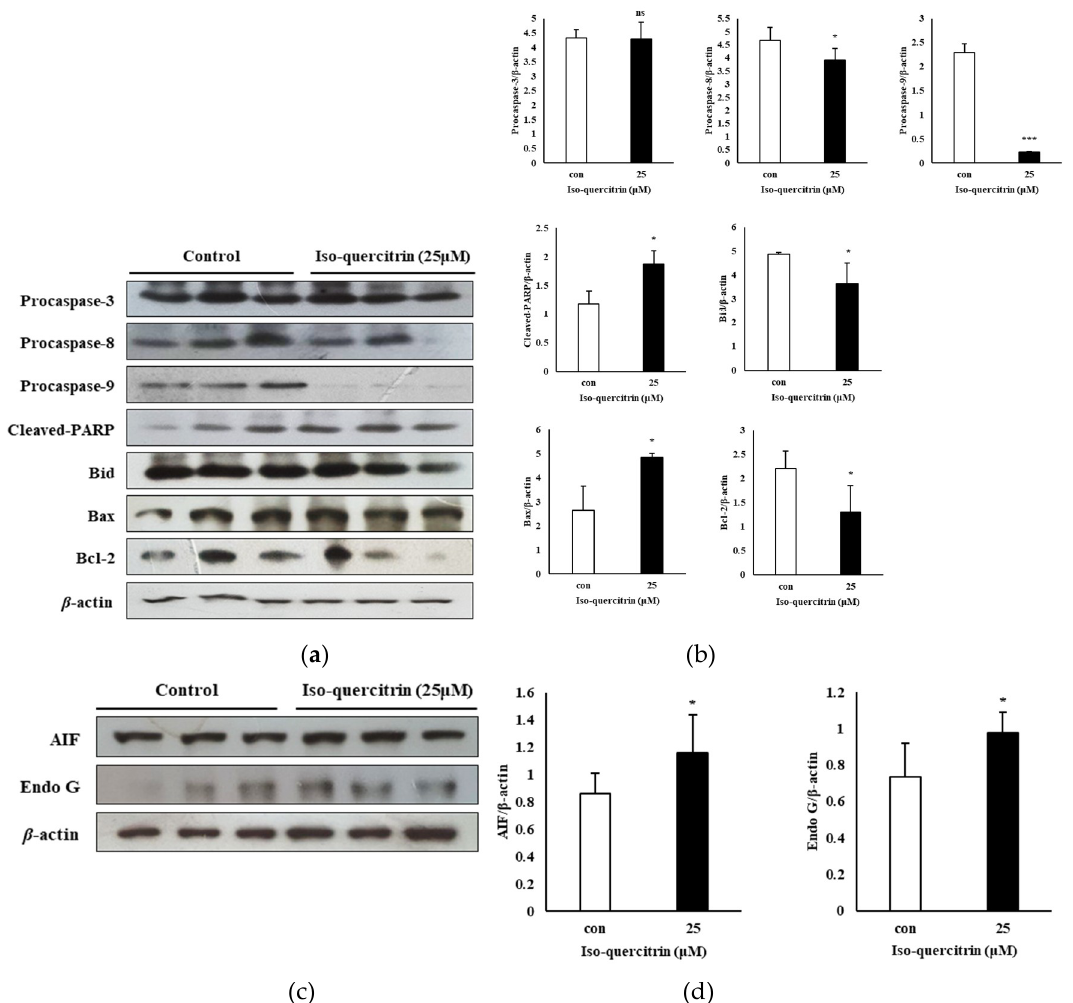
Figure 6. Isoquercitrin induces mitochondrial-mediated apoptosis in SK-MEL-2 cells. SK-MEL-2 cells were cultured in RPMI medium for 24 h and treated with 25 μM of isoquercitrin. Effect of IQ on the expression of ( a ) procaspase-3, -8, and -9, cleaved PARP, Bid, Bax, and Bcl-2; and ( c ) AIF and Endo G in SK-MEL-2 cells was analyzed through the western blot technique. ( b and d ) Total apoptotic proteins were quantified using the ImageJ software program. Results are expressed as a percentage. Data values are expressed as mean ± SD of triplicate determinations. Significant difference was established using unpaired Student's t -test at * P < 0.05 and *** P < 0.001.